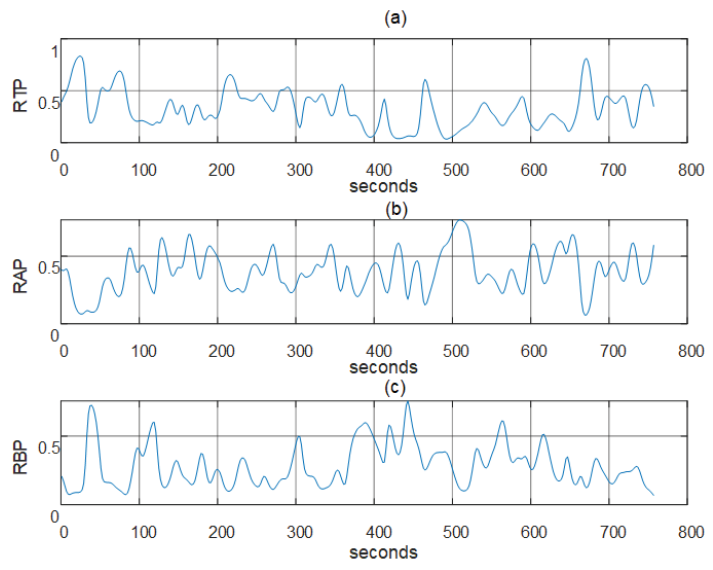
Figure 8. Example of relative powers obtained from F4 electrode. ( a ) F4 Theta relative power, ( b ) F4 Alpha relative power, and ( c ) F4 Beta relative